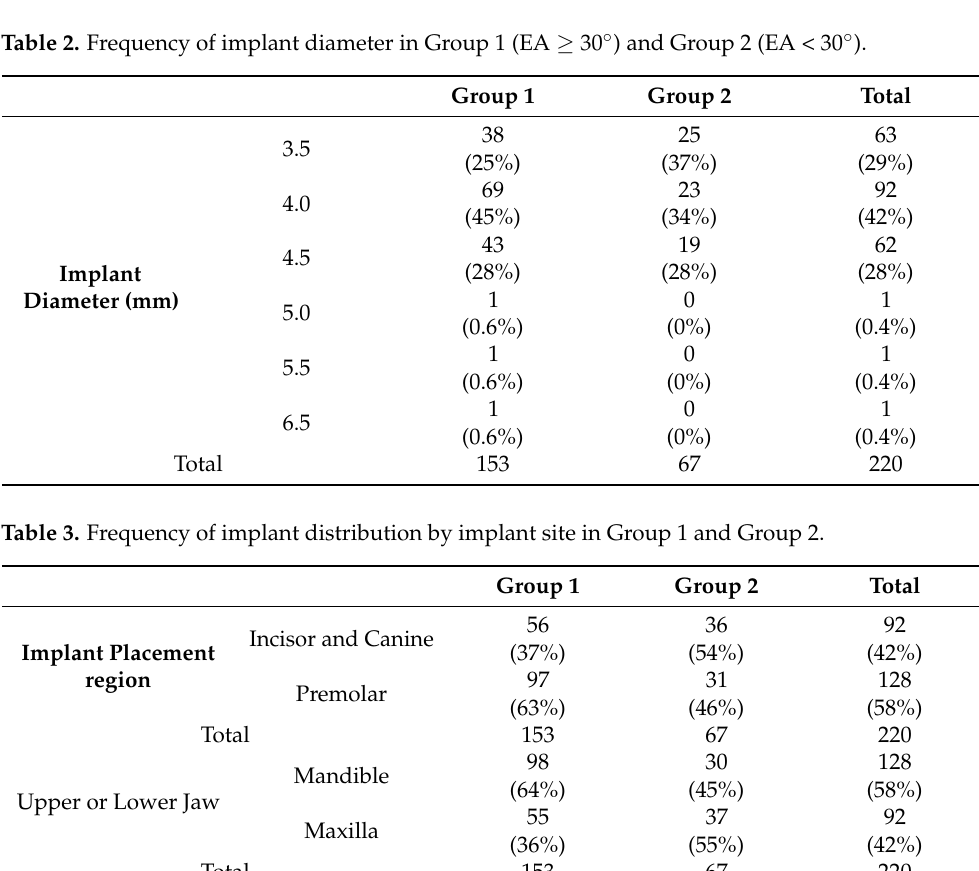
Upper or Lower Jaw